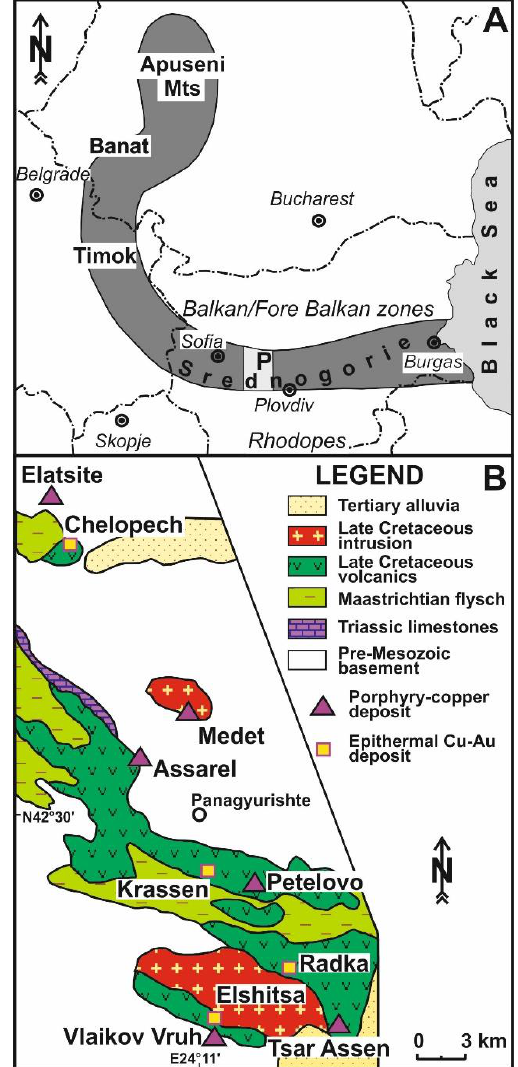
Figure 2. ( A ) The Apuseni–Banat–Timok–Srednogorie magmatic-metallogenic belt, showing also the location of the Panagyurishte (P) metallogenic district (after Handler et al. [24]). ( B ) Sketch map of the Panagyurishte district showing the locations of the main epithermal and porphyry mineral systems (after Strashimirov et al. [30]).